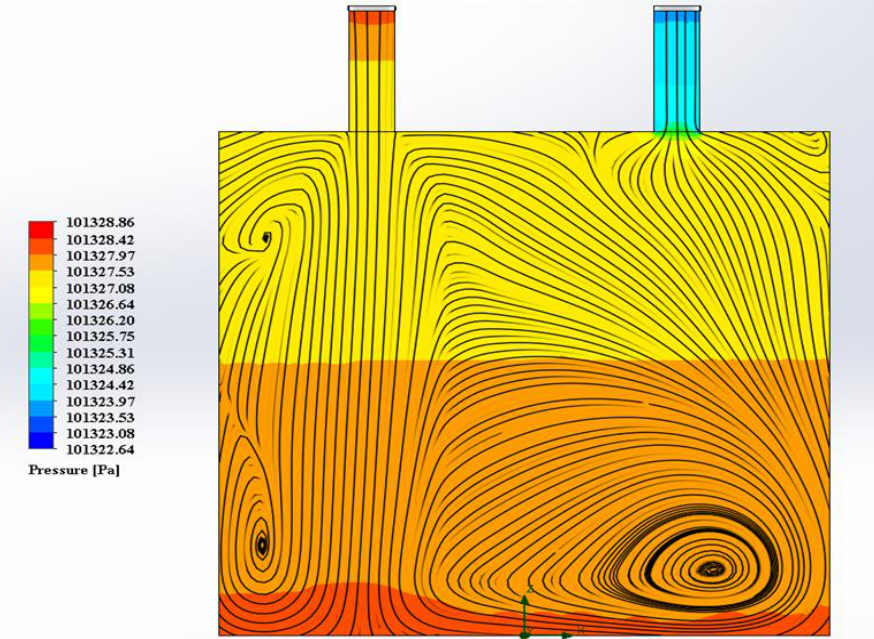
Figure 16. Internal pressure in the reaction cell and current lines, in run 1, for the geometry with upper air inlet and outlet. Q = 2.5 L/min; Di RC 8.0 cm; D I = 2.0 cm; D O = 2.0 cm.